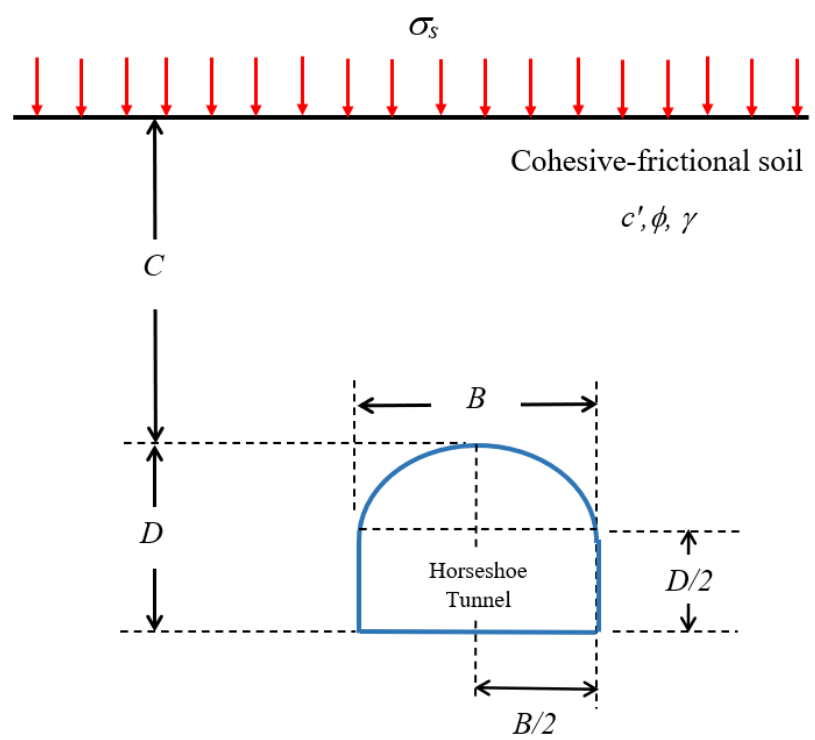
Figure 1. Problem definition of an unsupported infinitely long horseshoe tunnel in a Cohesive-frictional soil under plane strain condition.